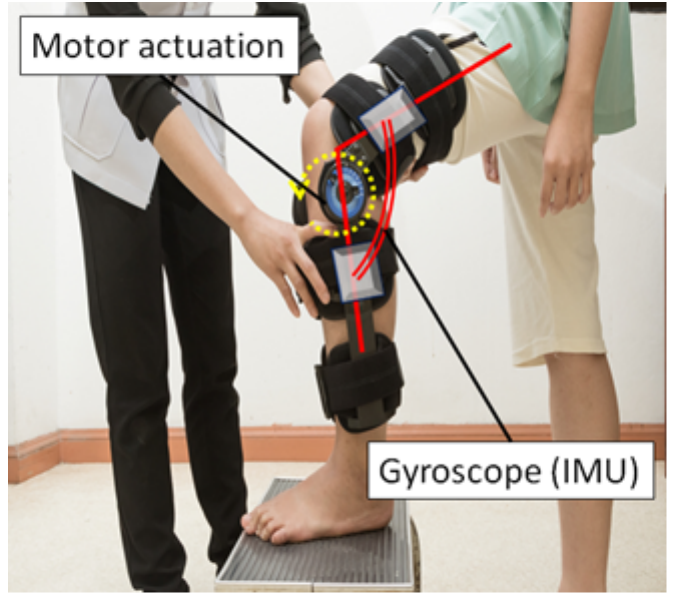
Figure 4. A motor actuated knee exoskeleton incorporating IMU gyroscope signals to determine actuation trigger thresholds based on joint angles and other kinematic data.